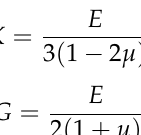
Figure 13. Three-dimensional view of finite element model.